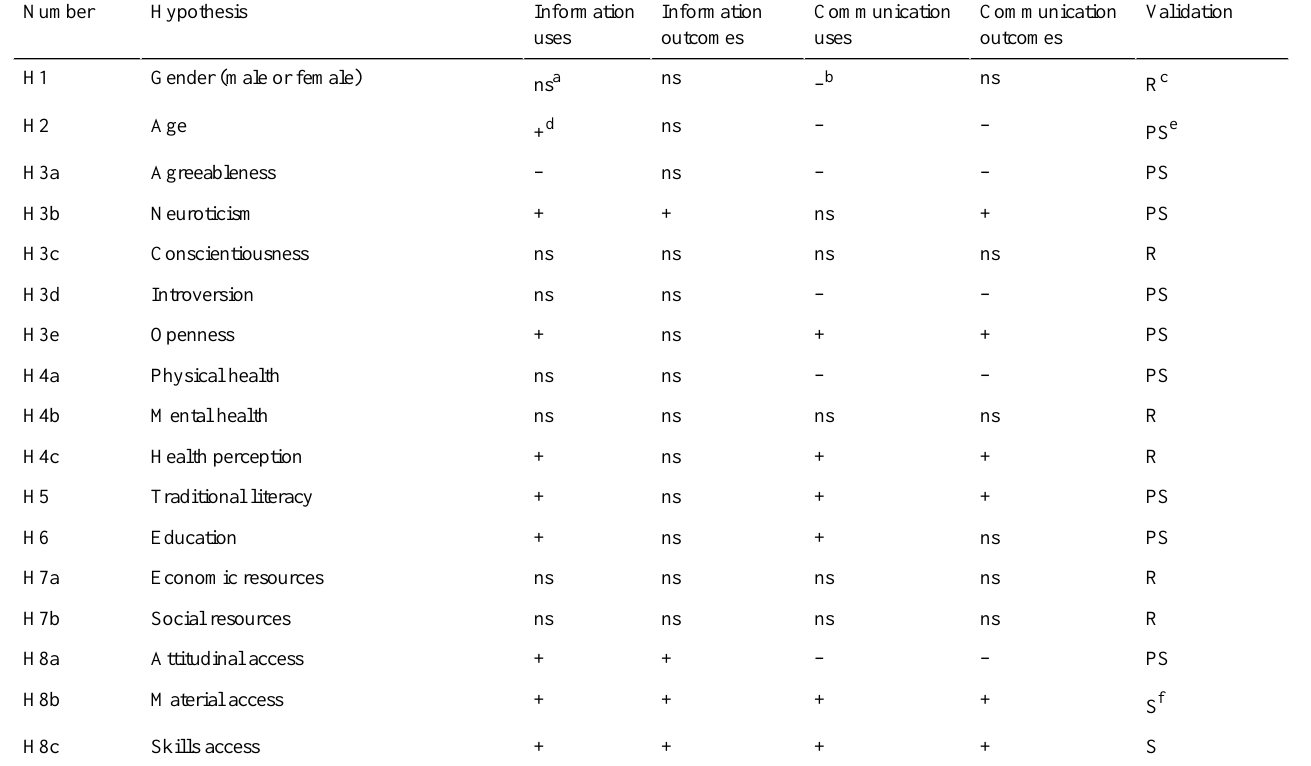
Table 4. Overview of the